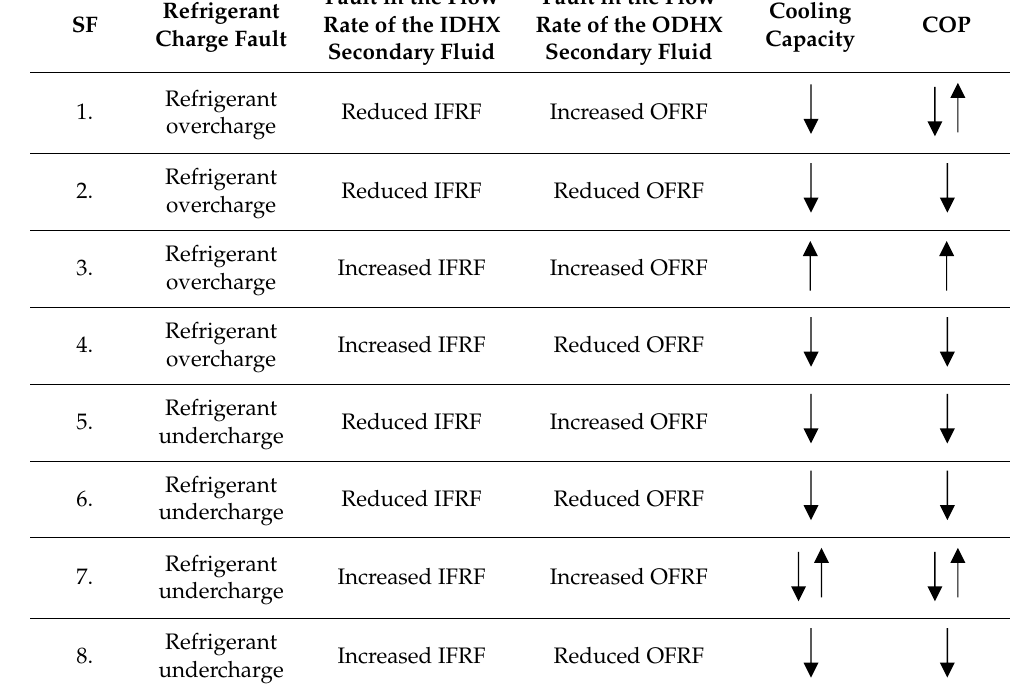
Table 3. Simultaneous faults in refrigerant charge and flow rate of secondary fluid of outdoor heat exchanger and indoor heat exchanger.